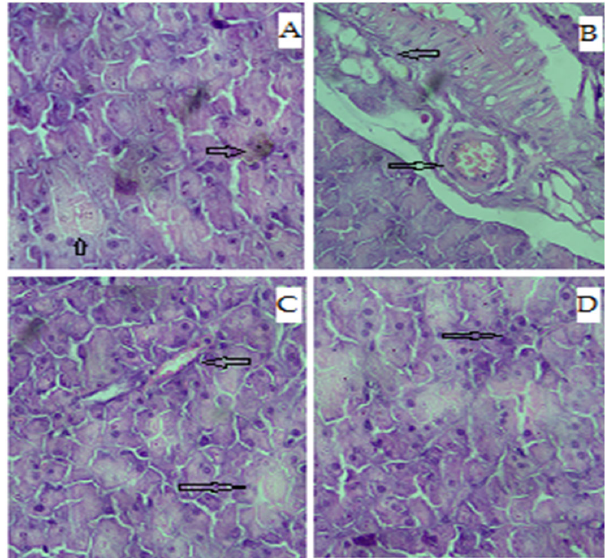
Figure 11. Photomicrographs of microsection of pancreas of rat ( A ) control group showing the normal histological structure of islets of Langerhans with normal pancreatic acini , ( B ) diabetic group showing ruptured and destructed islets of Langerhans with damage in beta cells , ( C , D ) Rp-Nc 0.5 mg and 1 mg treated groups showing some normal islets of Langerhans with some mild destructed in normal pancreatic duct and in between normal pancreatic acini (H & E scale bar 25 µ